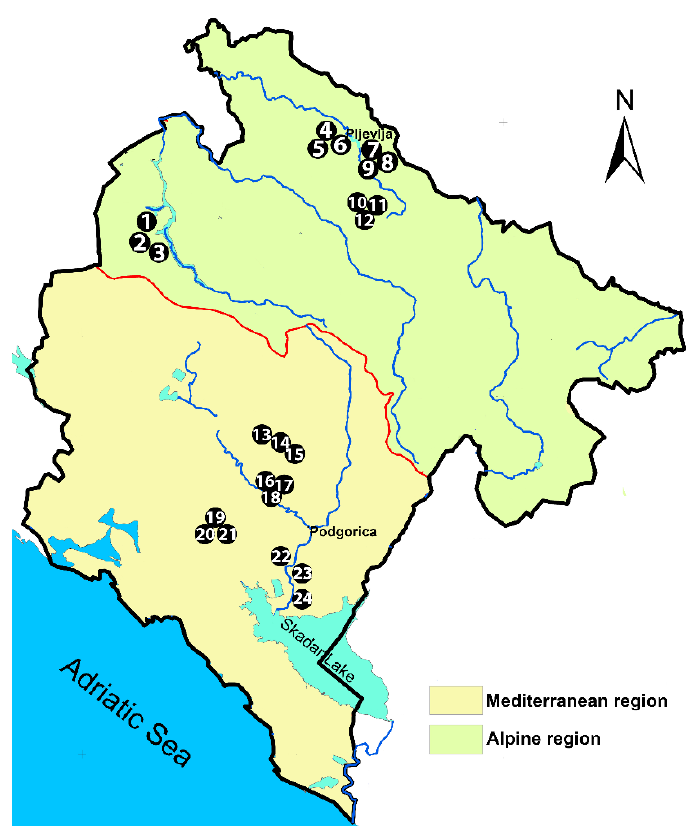
Figure 1. Map of Montenegro with marked locations of honey sampling from eight micro-regions (in parentheses are given sampling location numbers): Piva (1–3), Zbljevo (4–6), Potrlica (7–9), Mijakovi ć i